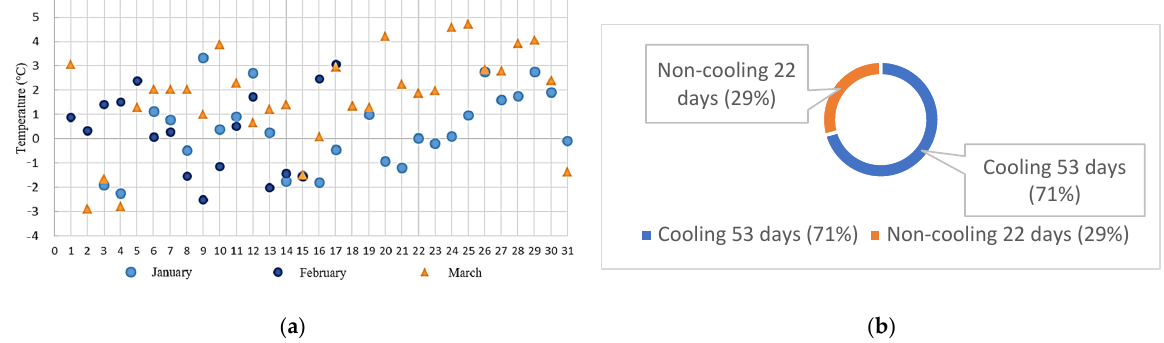
Figure 11. ( a ) Temperature distribution and ( b ) ratio of cooling days on the pervious road